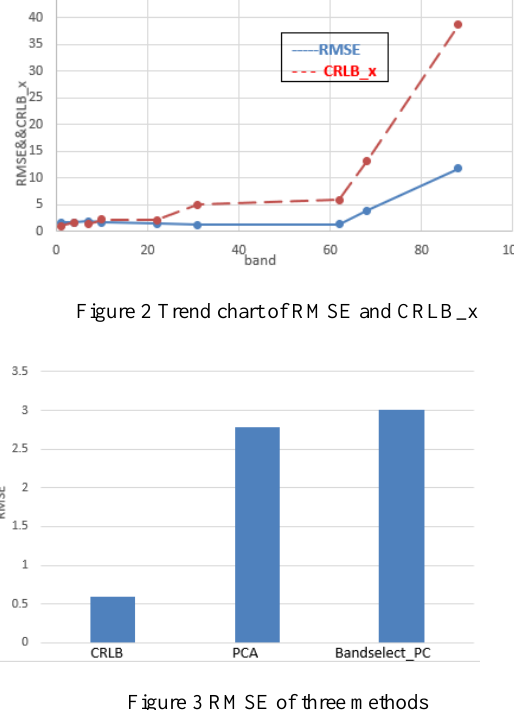
Figure 3 RMSE of three